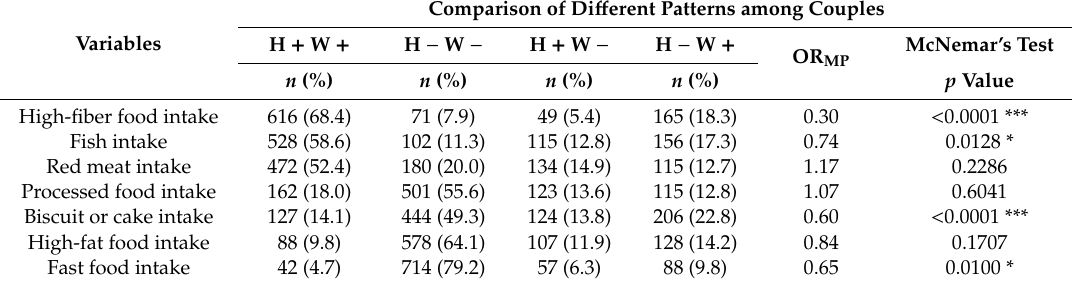
Table 2. Spousal concordance in dietary behaviors, and comparisons among di ff erent patterns ( n = 901 pairs).